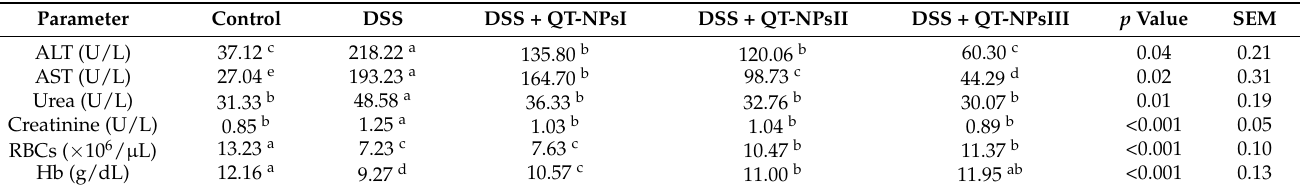
Table 3. Results of liver and kidney function and hematological tests in response to oral administra- tion of different levels of quercetin nanoparticles (QT-NPs) in DSS-induced rat models of